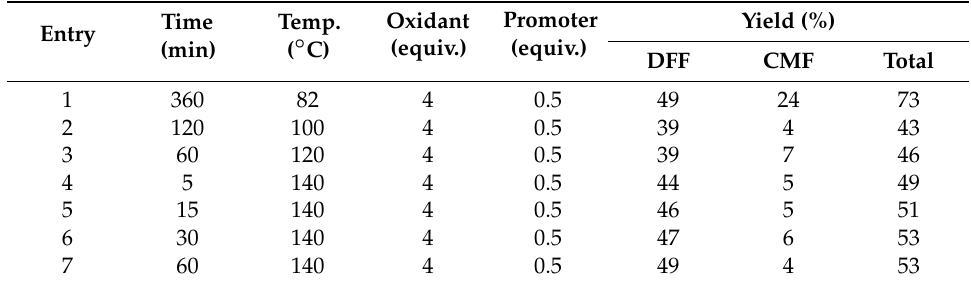
Table 2. Selected reaction conditions and yields of DFF, CMF, and HMF for the oxidation reactions of CMF performed under microwave irradiation